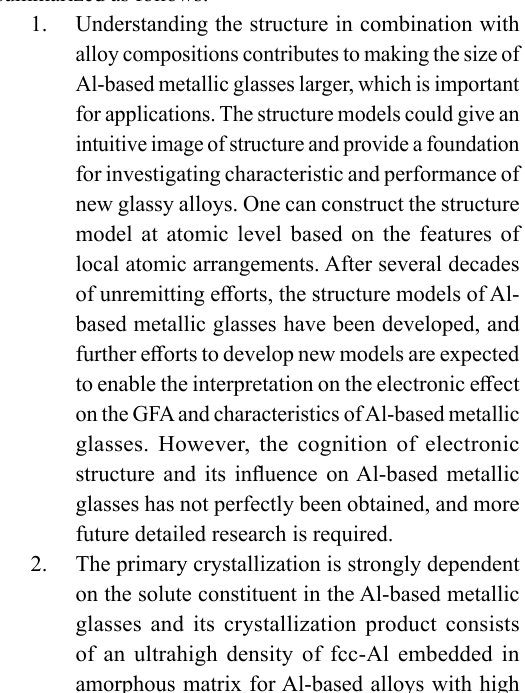
Figure 9. Schematic of the coupled-flux model.